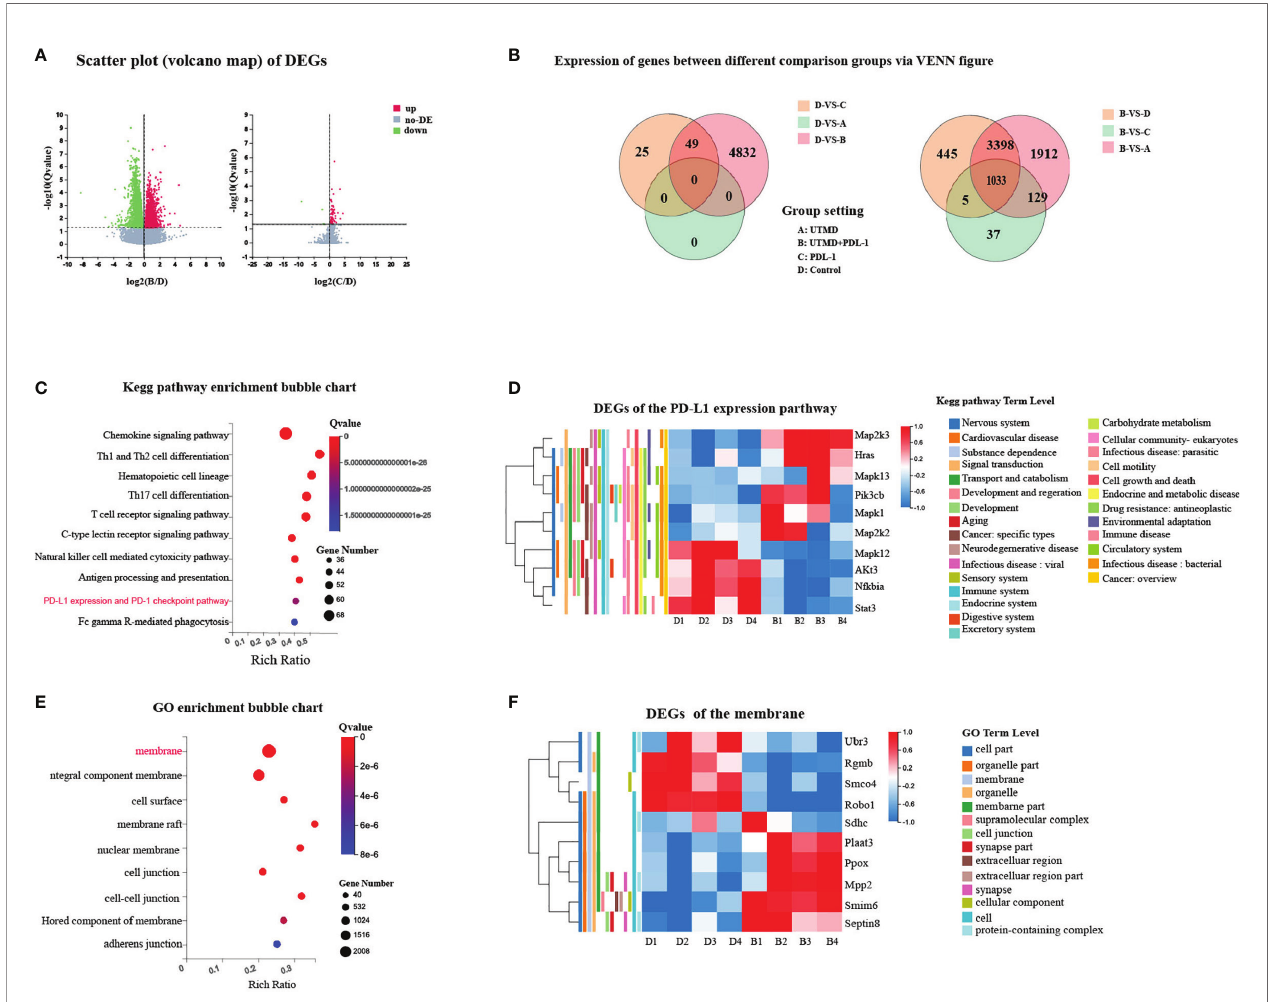
FIGURE 7 | Different expression of genes between groups associated with immune activities and membrane. (A) Scatter plot of DEGs. The x-axis represents the fold change of the difference after conversion to log2, and the y-axis represents the signi fi cance value after conversion to-log10. Red represents DEG upregulated; green represents DEG downregulated. (B) Differentially expressed genes (DEGs) between different comparison groups via VENN fi gure. Each circle represents a group of gene sets. (C) Represented Kyoto Encyclopedia of Genes and Genomes (KEGG) pathway enrichment bubble chart of DEGs between groups B and D. (D) Heat map of representative DEGs between groups B and D regarding PDL-1 expression pathway with annotation. (E) Represented Gene Ontology (GO) enrichment bubble chart of DEGs between groups B and D. (F) Heat map of representative DEGs between groups B and D with annotation. Each column represents data from an individual